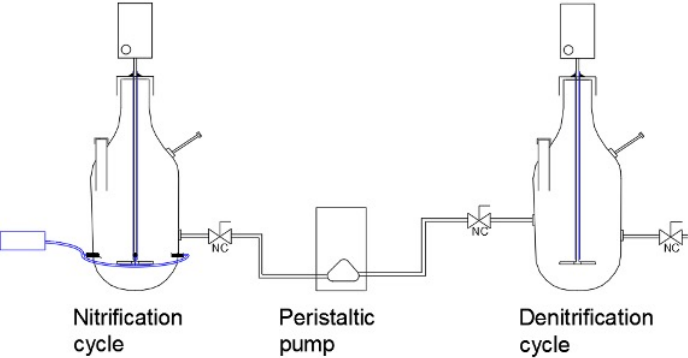
Figure 1. Configuration of SBR reactors. Sequential process circuits constructed: Nitrification (NT) reactor and Autotrophic denitrification (aDN) reactor.